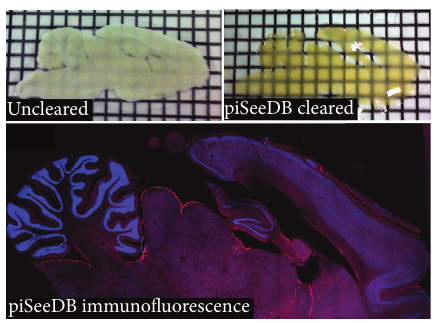
Figure 1: A comparison of the transparency of uncleared and piSeeDB cleared